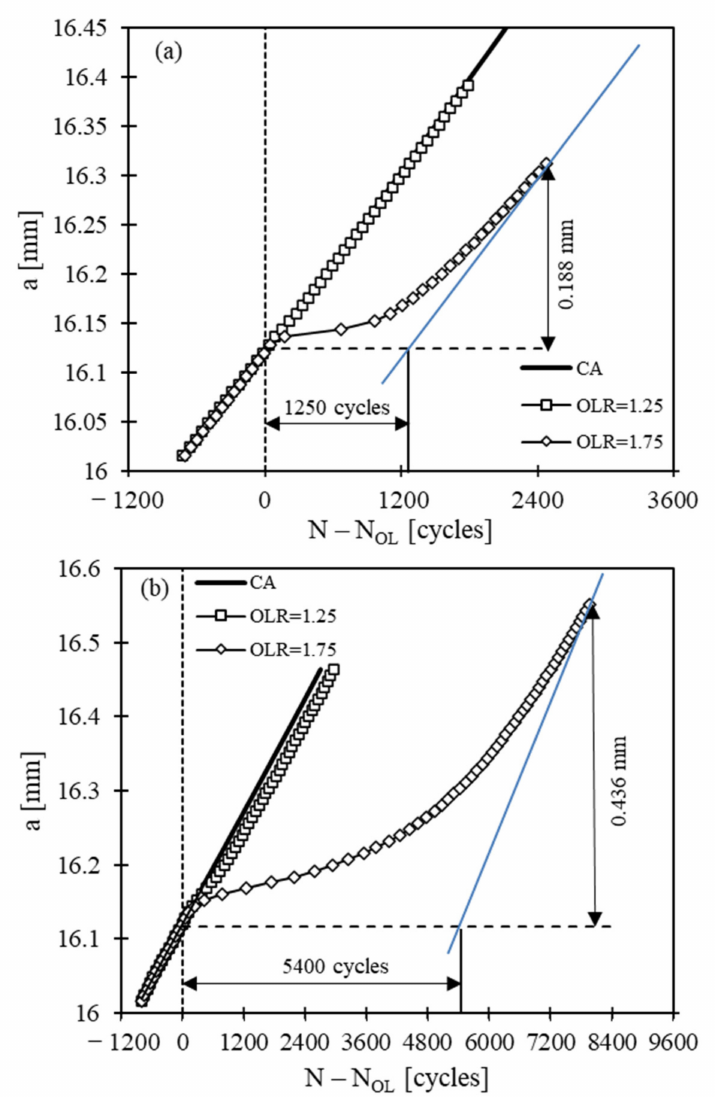
Figure 9. Numerical prediction of crack growth with the application of a single tensile overload √ (a OL = 16.12 mm; ∆ K BL = 18.3 MPa m), applying boundary conditions for: ( a ) Plane strain state; ( b ) Plane stress state (CA = Constant Amplitude; OLR = Overload Load